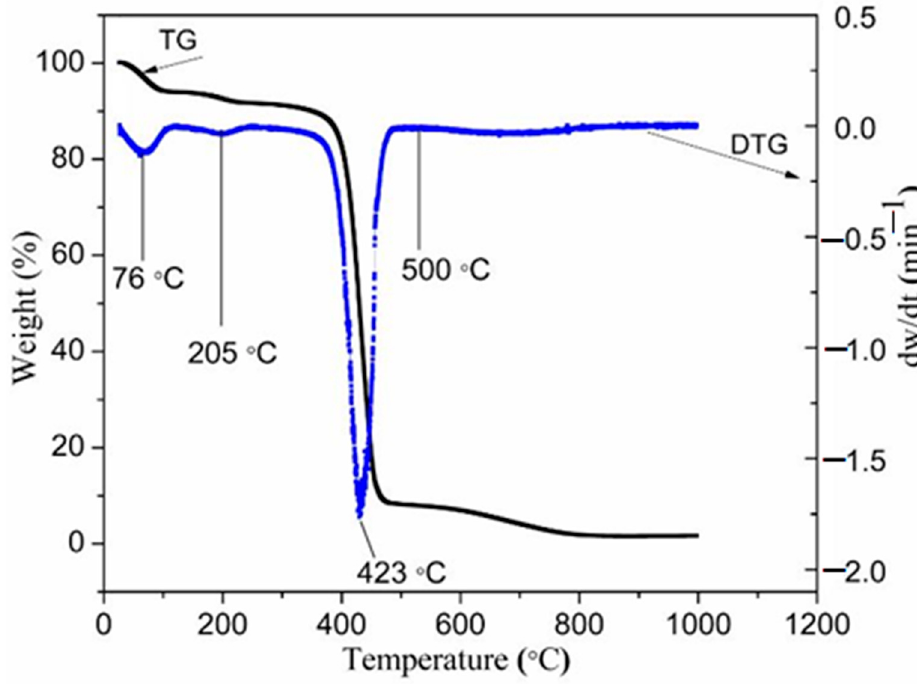
Figure 2. Thermogravimetric (TG) and its derivative (DTG) curves for PVP at a heating rate of 10 °C/min.